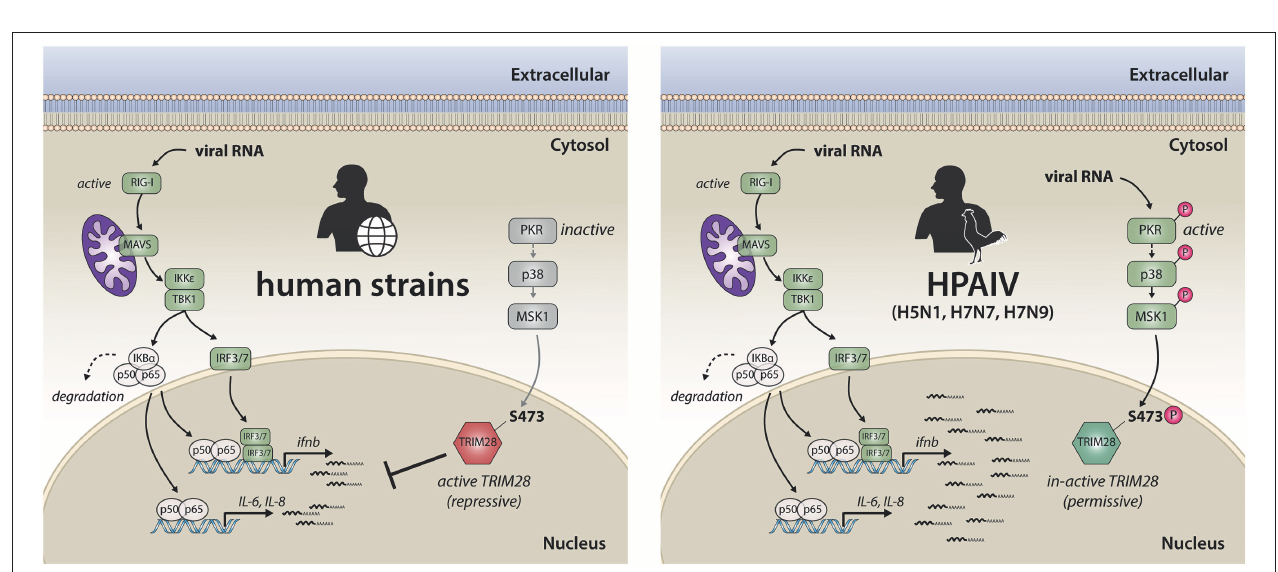
FIGURE 9 | Model for TRIM28-mediated upregulation of IFN- β and proinflammatory cytokines during infection with the HPAIV subtypes H5N1, H7N9 and H7N7. Early during IAV infection, viral RNAs are sensed by RIG-I. This initiates a signaling cascade, which includes the adaptor protein MAVS and results in the dimerization and nuclear translocation of the transcription factors IRF3/7. During infection with human adapted strains, this leads to non-pathological levels of IFN- β and proinflammatory cytokines, which usually leads to the clearance of IAV infection (left). In contrast, during infection with the HPAIV of the subtypes H5N1, H7N7 and H7N9 (right), the expression of IFN- β , IL-6 and IL-8 is potentiated. This is facilitated by PKR-mediated sensing of viral RNA followed by signal transduction via p38 and MSK1 resulting in phosphorylation of the transcriptional corepressor TRIM28 at serine 473. This leads to the release of TRIM28 corepressor activity and finally results in elevated expression of IFN- β , IL-6 and IL-8, which is commonly associated with tissue damage und high mortality during HPAIV infections.